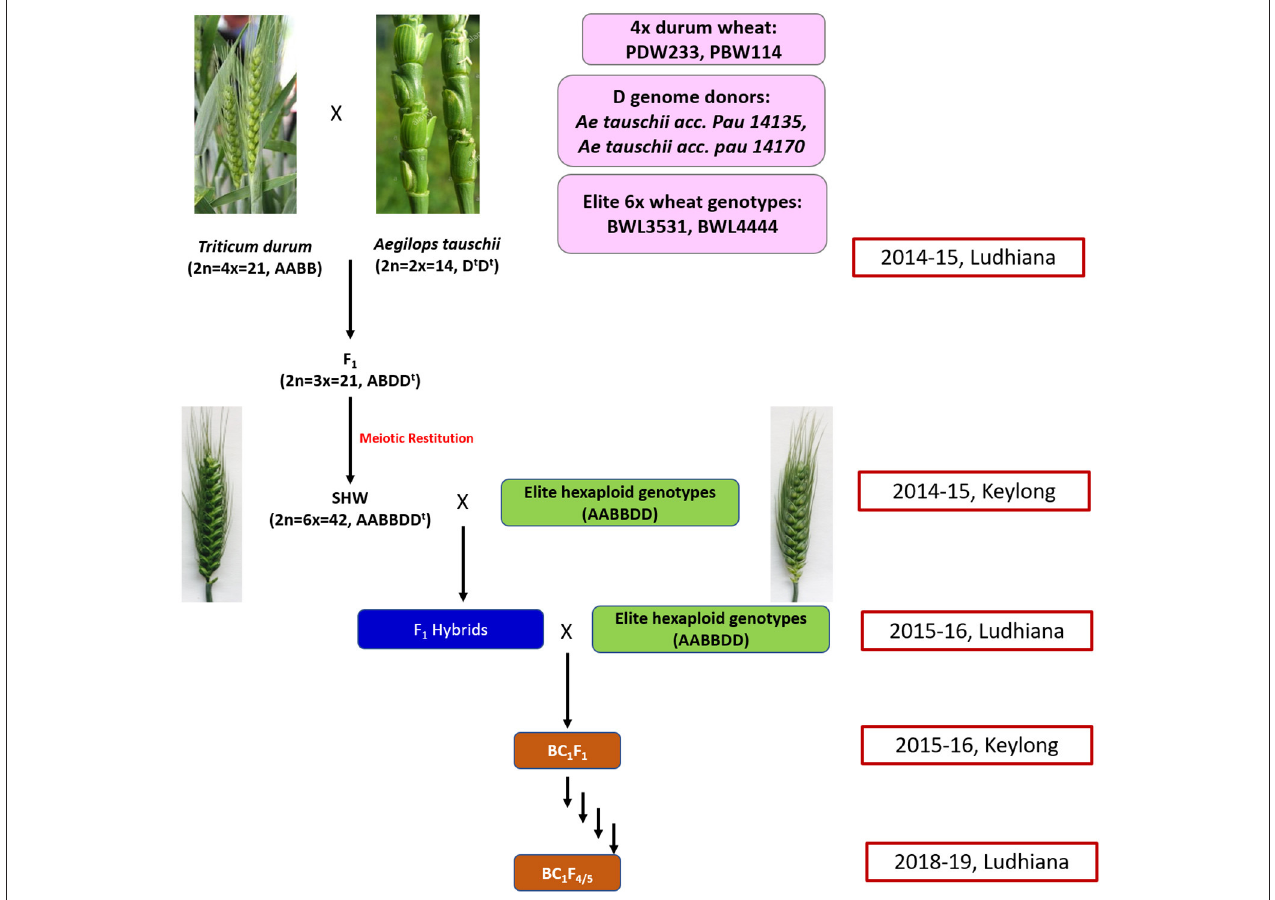
FIGURE 1 | Schematic representation of the breeding strategy that is used to develop the nested synthetic wheat introgression libraries.